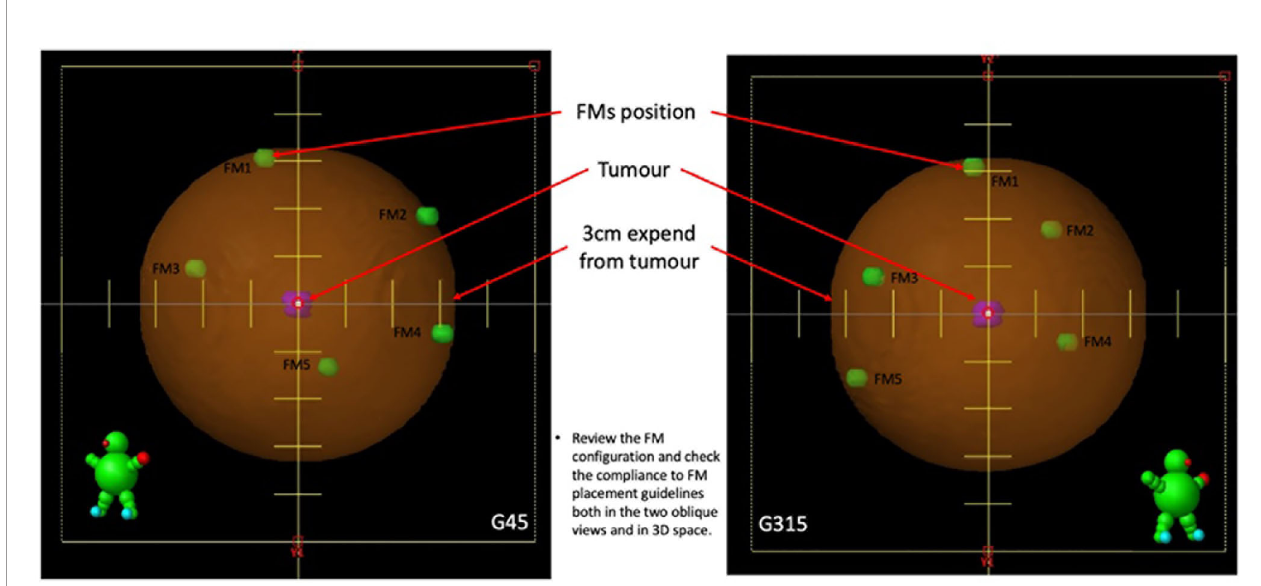
FIGURE 3 | Illustrations of the FM con fi guration review in the two oblique views.